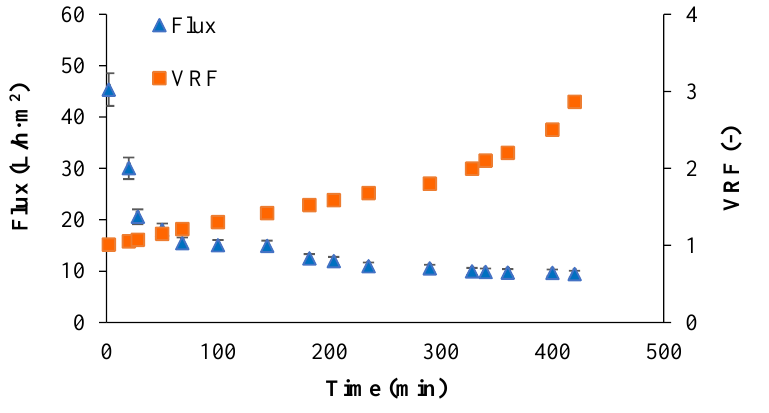
Figure 5. Permeate flux and VRF obtained during the filtration of tomato leaves aqueous extract by RC membrane as a function of time.